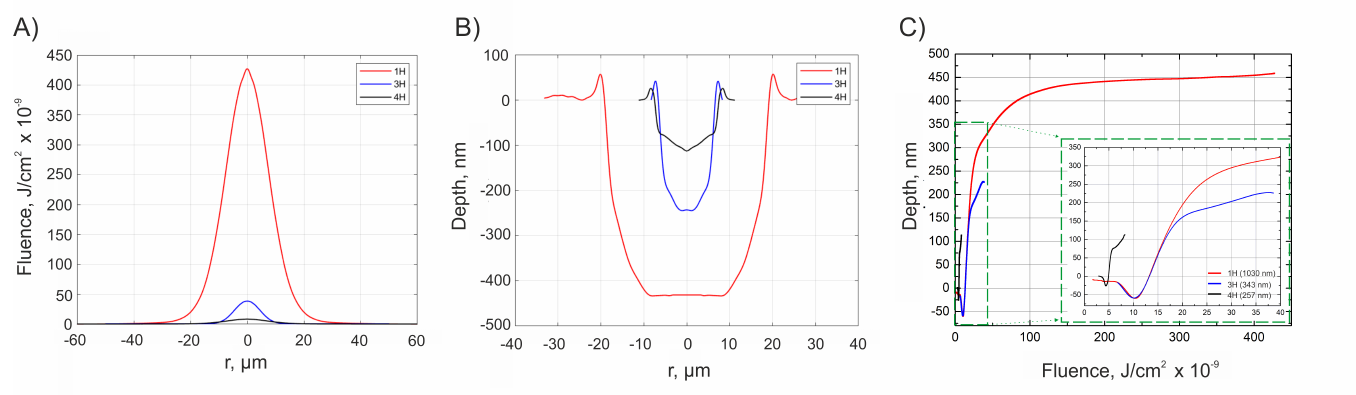
Figure 8. Beam profiles using different laser wavelengths ( A ), profiles of single-shot modifications using different laser wavelengths ( B ), and material response functions when different wavelengths are used ( C ). The subfigure in part ( C ) provides a closer look of material response functions at lower fluence and depths values. Red curve—1H, blue curve—3H, black